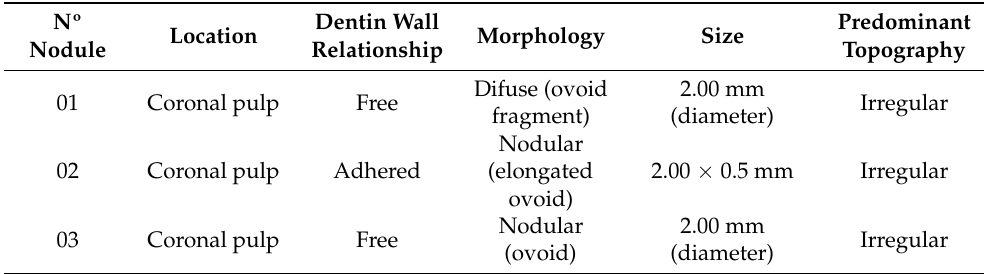
Table 1. Descriptive table indicating location, relationship with dentin wall, morphology, size and predominant topography of